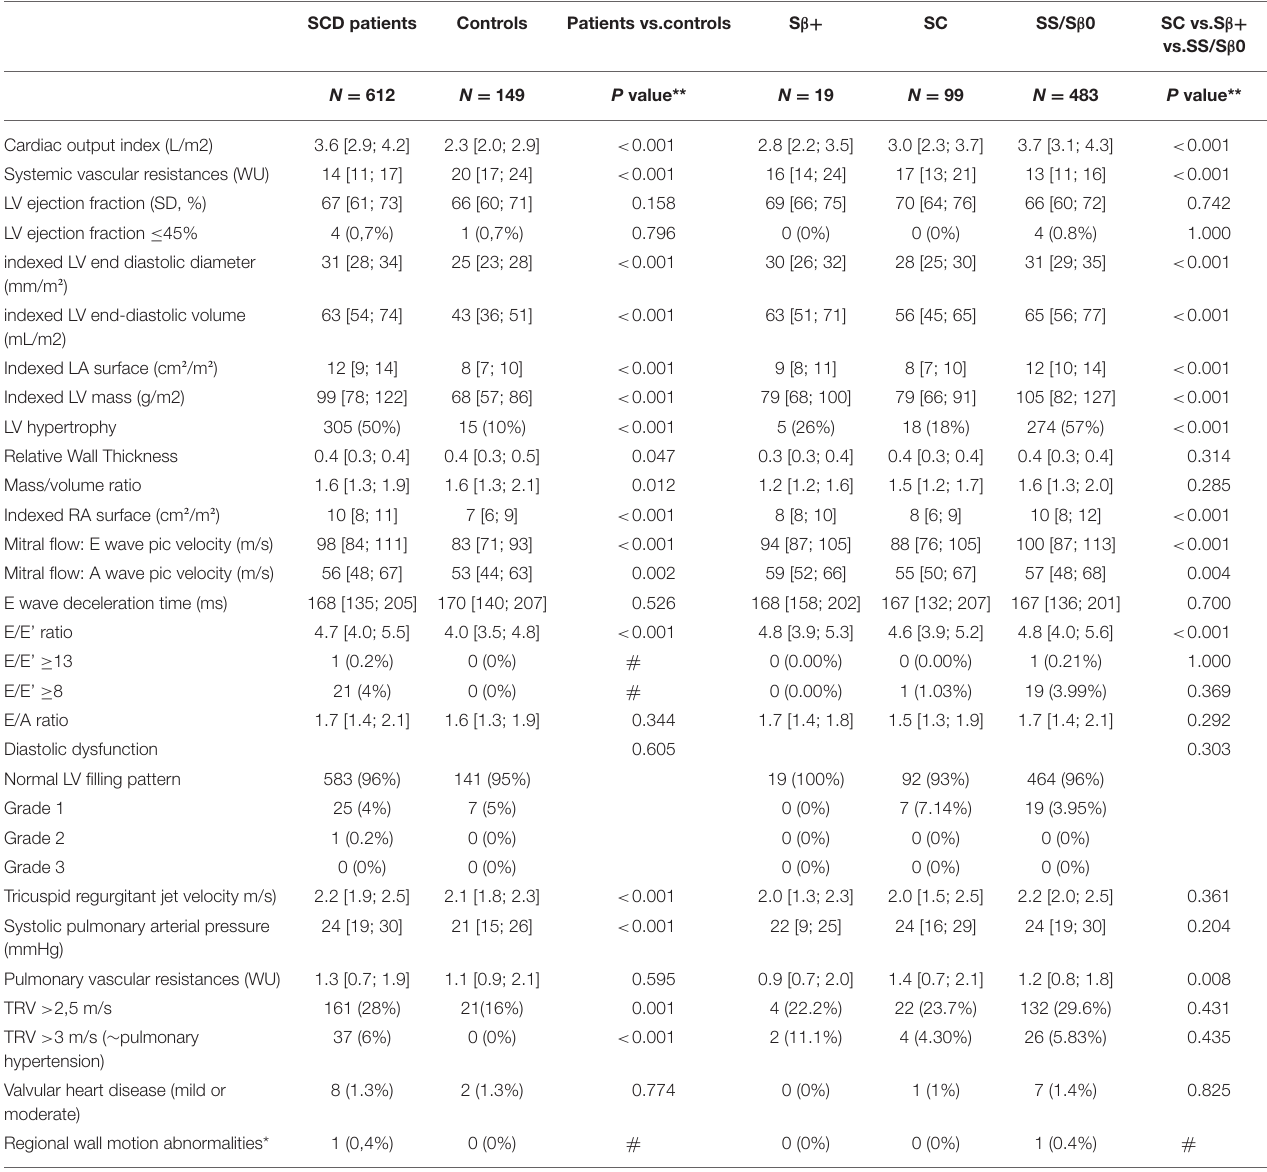
TABLE 2 | Echo-Doppler data in 761 subjects with